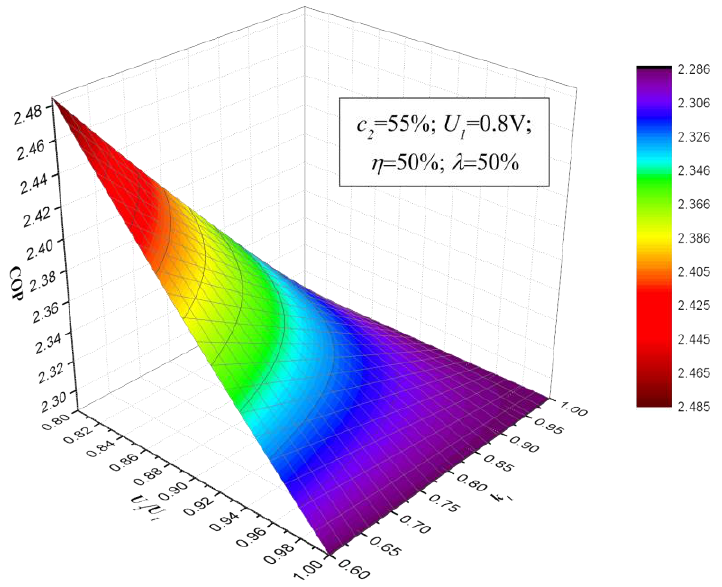
Figure 10. COP of the double-stage CDI system with correction parameters.